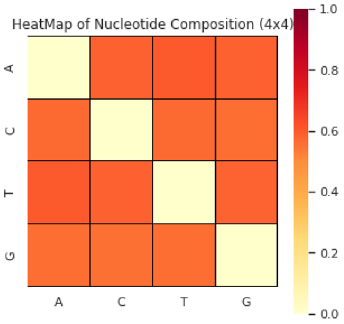
Figure 1. The heatmap of nucleotide composition based PRIMs.